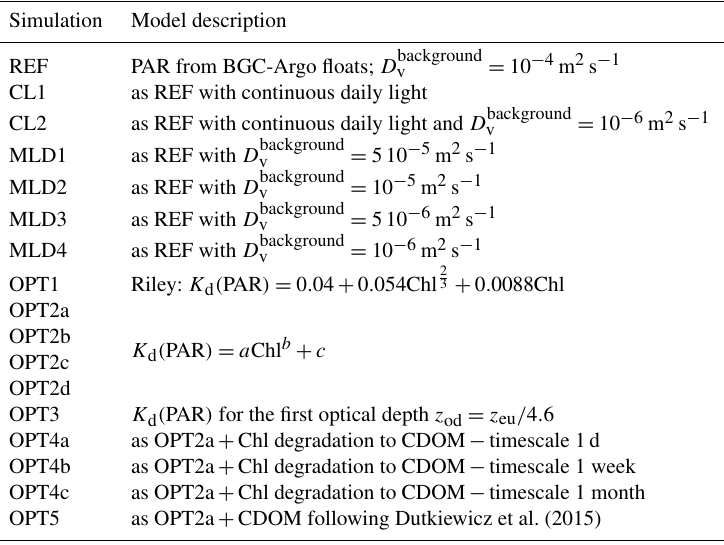
Table 1. Model configurations considered in the present work. All simulations include diurnal variability except the two cases with continuous light (CL1 and CL2), which use 24h averaged irradiance values.